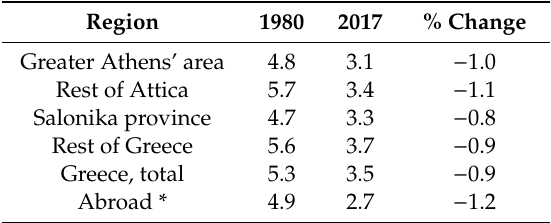
Table 2. Gender gap (years) in the mean age at marriage for selected regions of Greece, by year (* marriages celebrated abroad by at least one spouse with Greek citizenship).